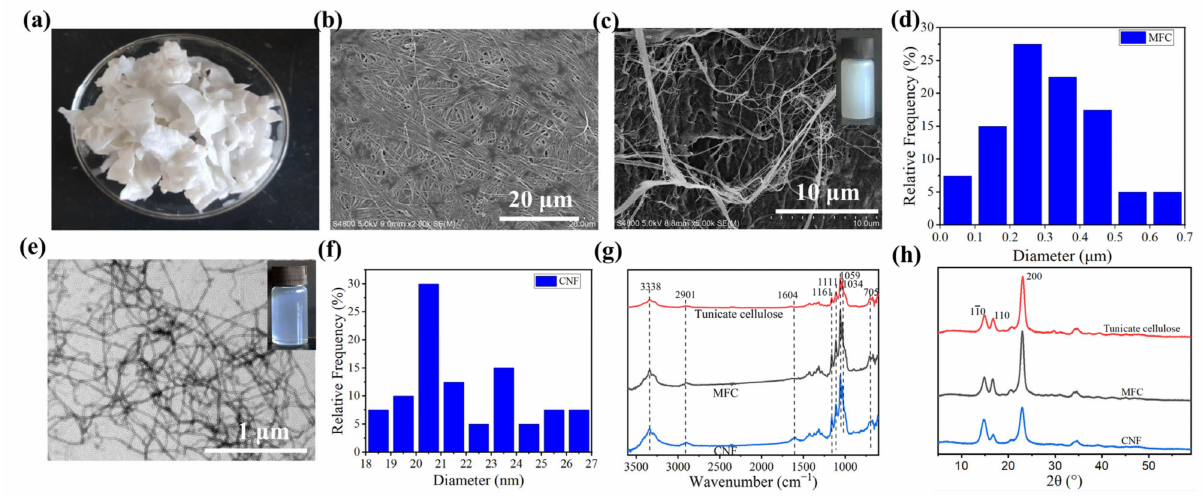
Figure 2. Digital image ( a ) and SEM image ( b ) of tunicate cellulose; SEM image ( c ) and diameter distribution ( d ) of MFC, digital image in the upper right corner is the 0.5 wt.% MFC suspension; TEM image ( e ) and diameter distribution ( f ) of CNF, digital image in the upper right corner is the 0.5 wt.% CNF suspension; FTIR spectra ( g ) and XRD patterns ( h ) of tunicate cellulose, MFC and CNF samples. In addition, the crystalline structures of tunicate cellulose, MFC and CNF were tested by XRD analysis. In all patterns (Figure 2h), the peaks at 14.76 ◦ and 16.76 ◦ are assigned to (1¯ı0) and (110) planes, respectively [28,30,34]. The peak around 22.96 ◦ is assigned to (200) plane of cellulose I structure. According to the XRD pattern, the calculated crystallinity index (CrI) values of tunicate cellulose, MFC and CNF are 85.1%, 85.4%, and 78.4%,